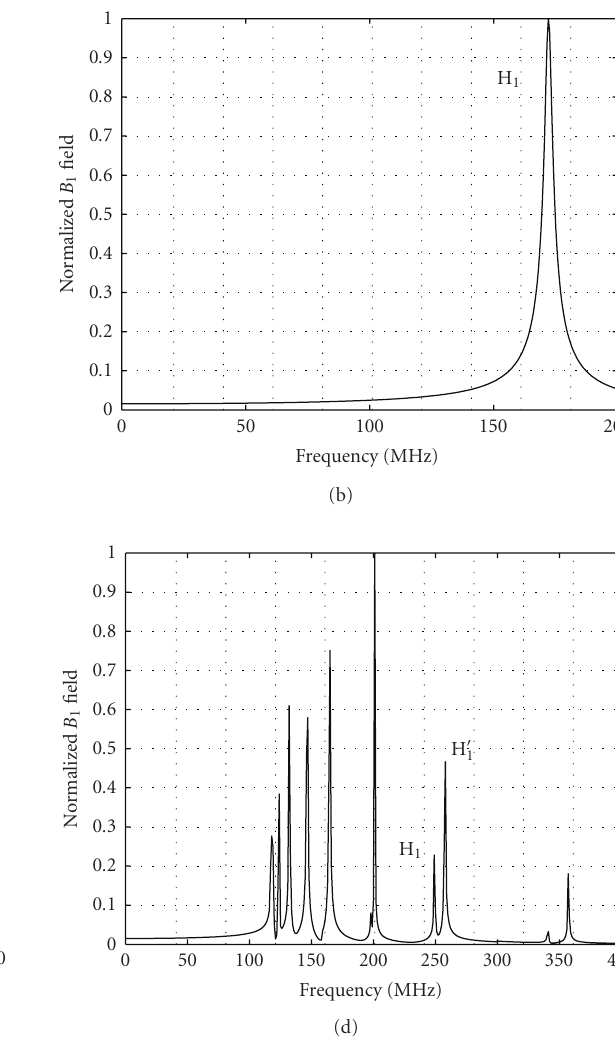
Figure 3: (a) Measured S 11 of the coil (obtained with a network analyzer). H 1 is the mode of interest (mode 1); (b) calculated resonance pattern with N p = 5 and N s = 5 grids. Only one mode resonated at 174 MHz; (c) calculated resonance pattern with N p = 10 and N s = 8 grids. The number of modes and resonance frequencies is in excellent agreement with the measured S 11 ; (d) calculated resonance pattern with N p = 10 and N s = 1 grids. Mode 0 and mode 1 are split (e.g., mode 1 split into two peaks: H 1 and H (cid:6) 1